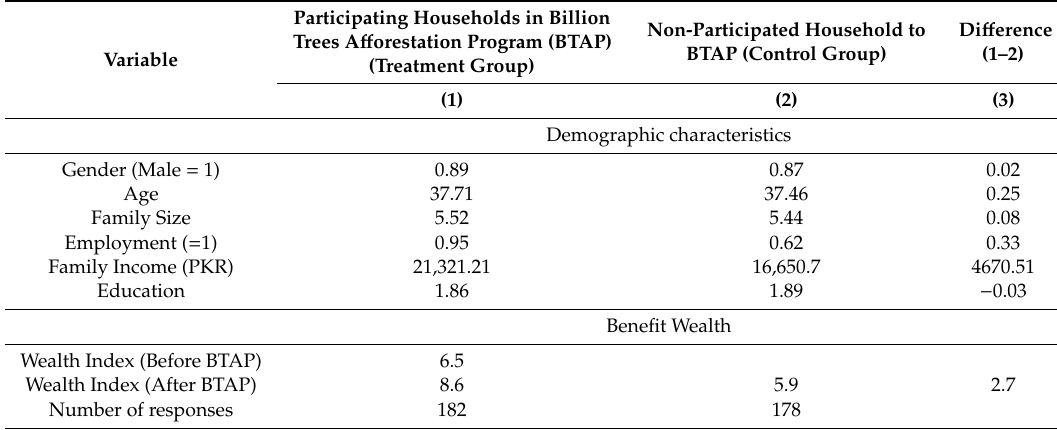
Table 1. Comparison of participated (treatment group) and non-participated households (control